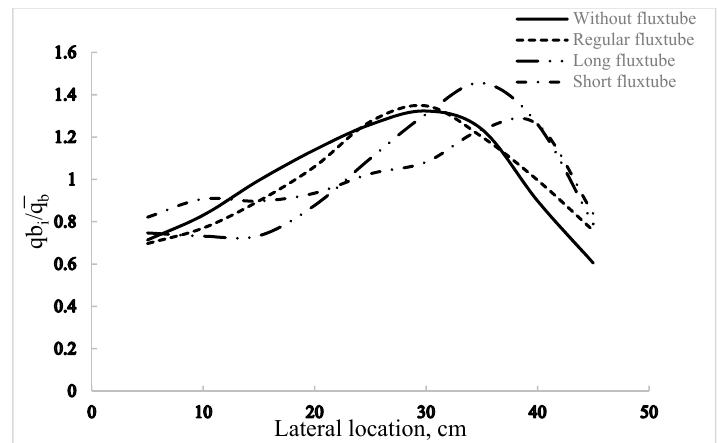
Figure 12. Radial gas bubble distributions at injection level using the asymmetrical baffle without a fluxtube and with fluxtube baffles of different lengths under the superficial gas velocity of 0.4 m/s for the even gas inlet configuration.